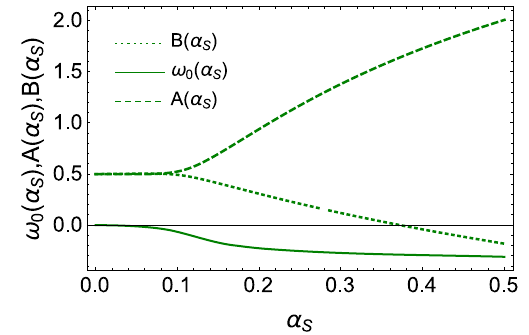
Fig. 6 ω 0 ( ¯ α S ), A ( ¯ α S ), B ( ¯ α S ) versus ¯ α S